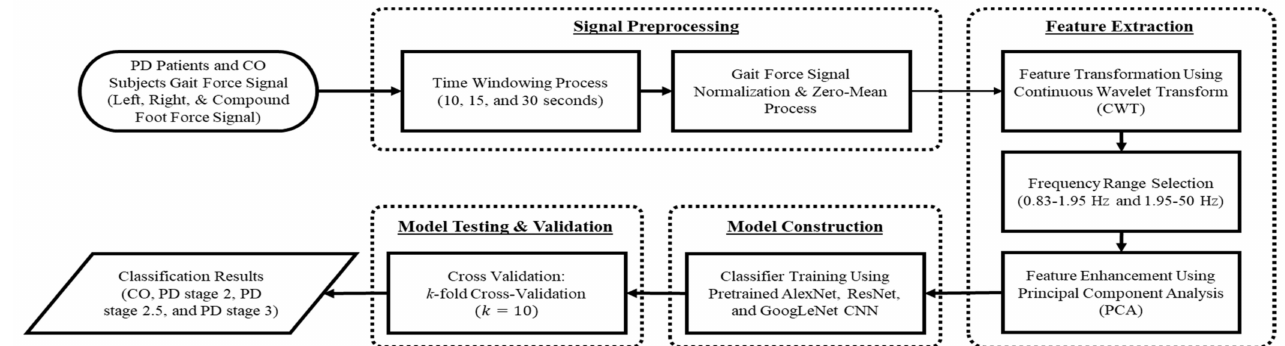
Figure 2. Flowchart of the proposed PD detection and severity classification algorithm using the continuous wavelet transform as the feature transformation.